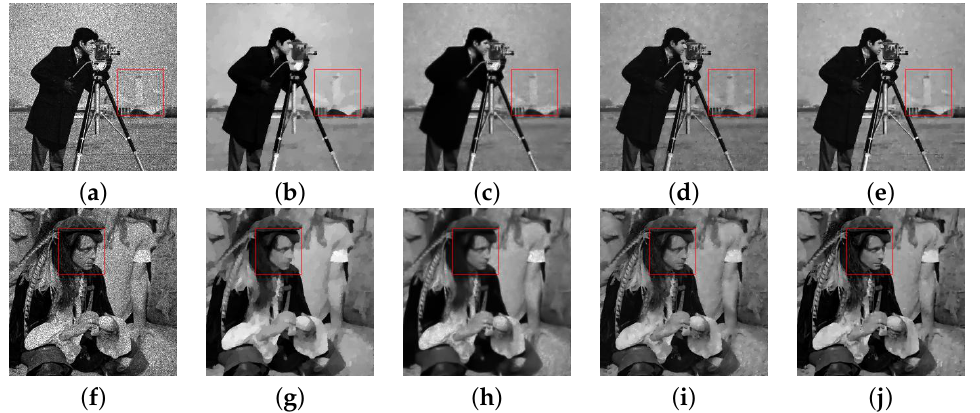
Figure 3. Recovery results of four algorithms on different images with the noise at L = 30: